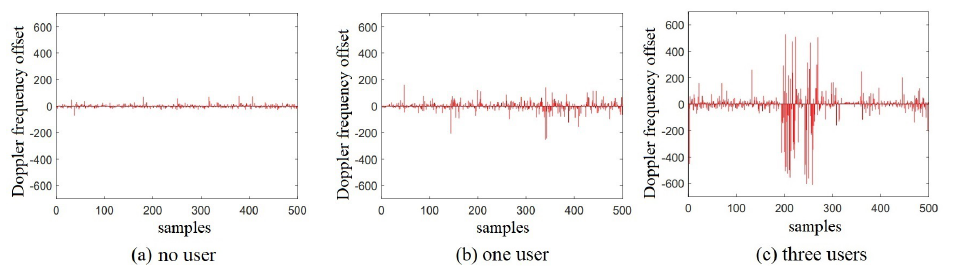
Figure 10. Impact of the number of users on Doppler frequency